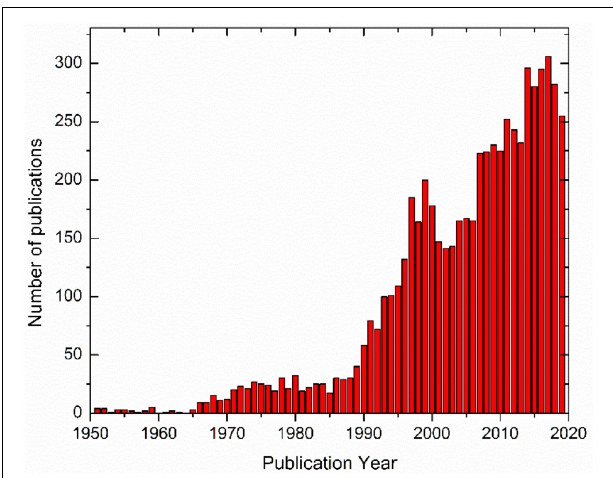
FIGURE 1 | Evolution of the number of publications revolving around KN, as retrieved from Web of Science TM .